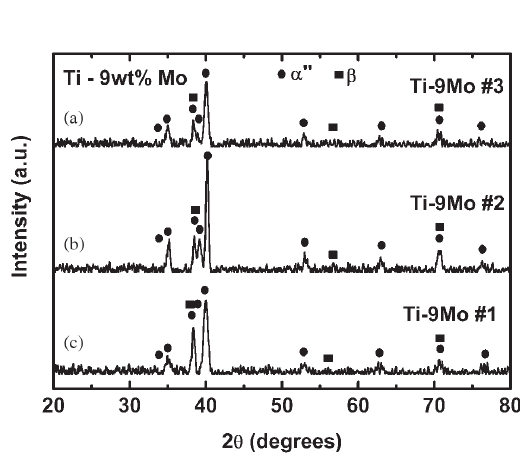
Figure 1. X-ray diffraction patterns for Ti-9Mo alloys (a) as received, (b) after annealing, and (c) after doping with